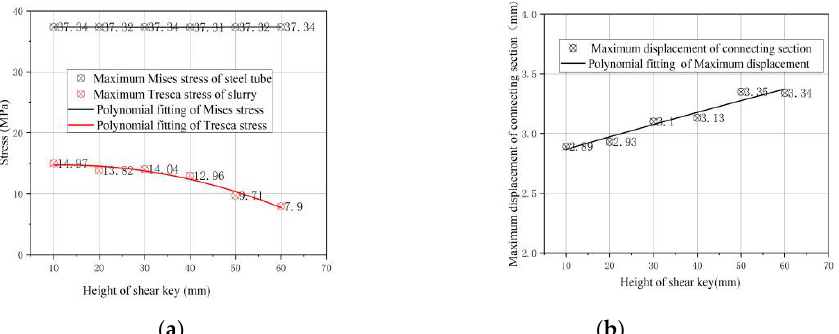
Figure 12. Variation trend of maximum stress/displacement of grouted joints with shear keys in different heights. ( a ) variation of stresses. ( b ) The change of displacement.